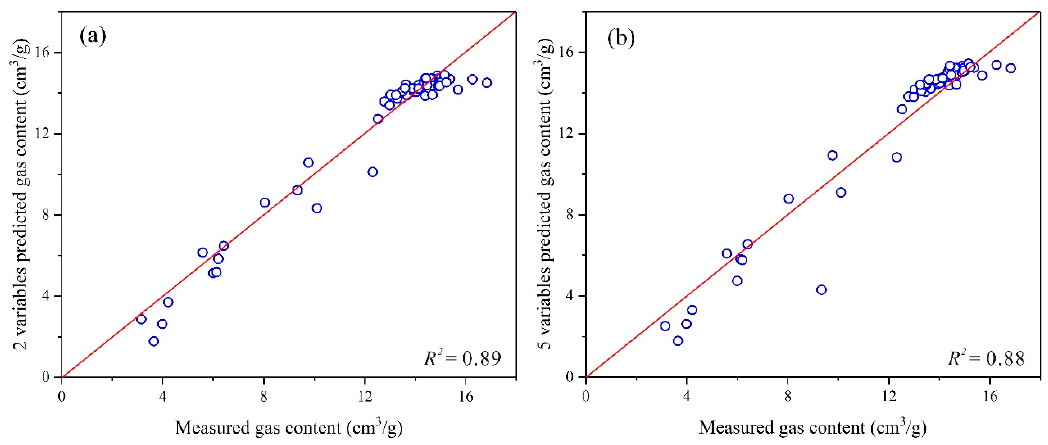
Figure 5. Comparison between measured and two variables’ predicted gas contents with logging method ( a ); comparison between measured and five variables’ predicted gas contents with logging method ( b ).